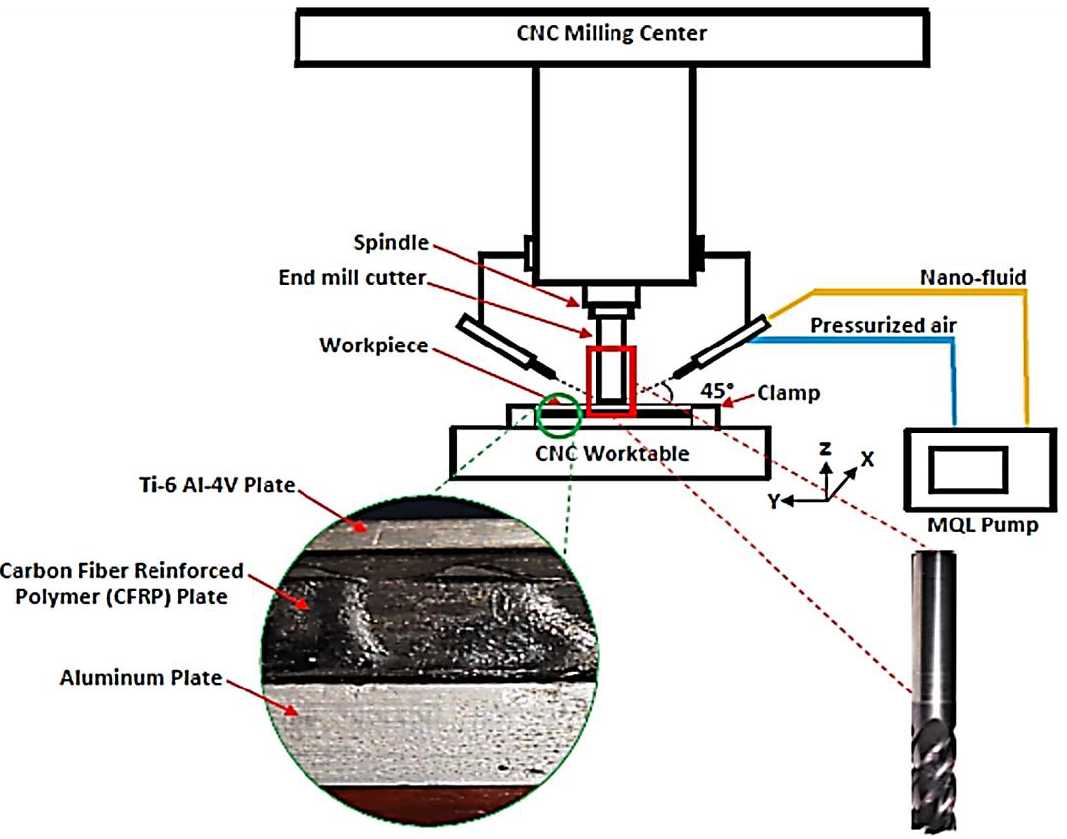
Figure 2. Process schematic for helical milling of CFRP/Ti stacks.